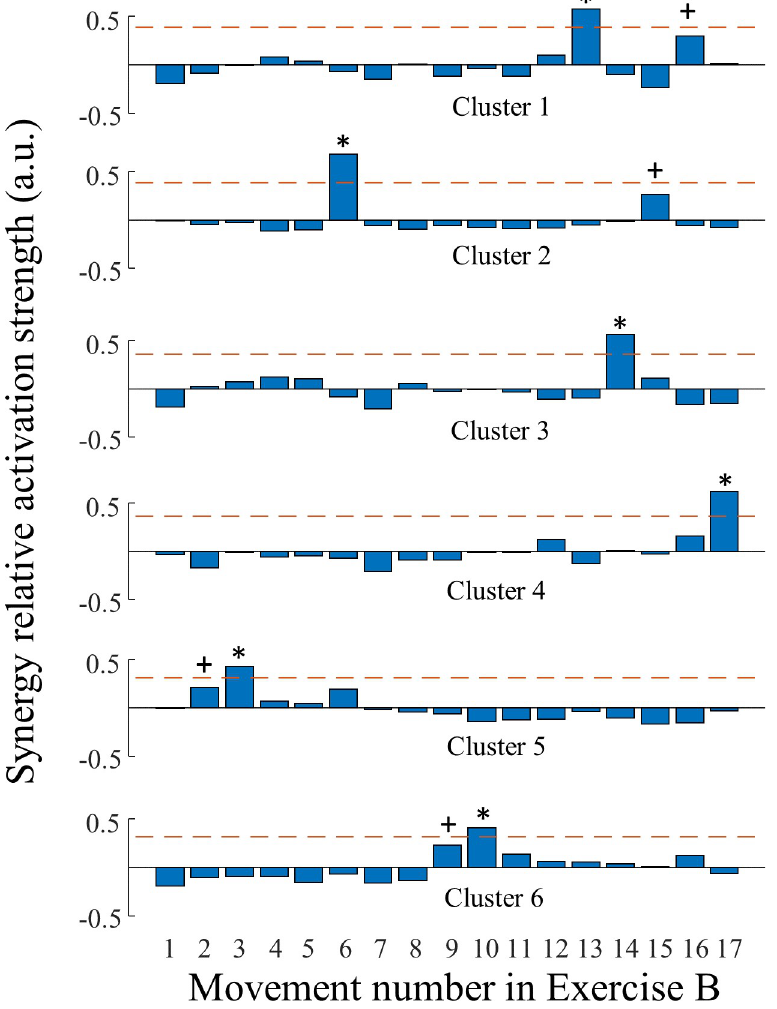
Fig 3. Activation strength of synergy types extracted from able-bodied subjects. Each row represents the relative activation strength for movements from Exercise B, averaged within a cluster of normalized synergies. The dashed horizontal lines represent the Mean + 2 S.D. of these averaged activation strength. The asterisks and crosses indicate the primary and secondary representative movements for the synergy clusters. The movement number is defined in Table 2 Exercise